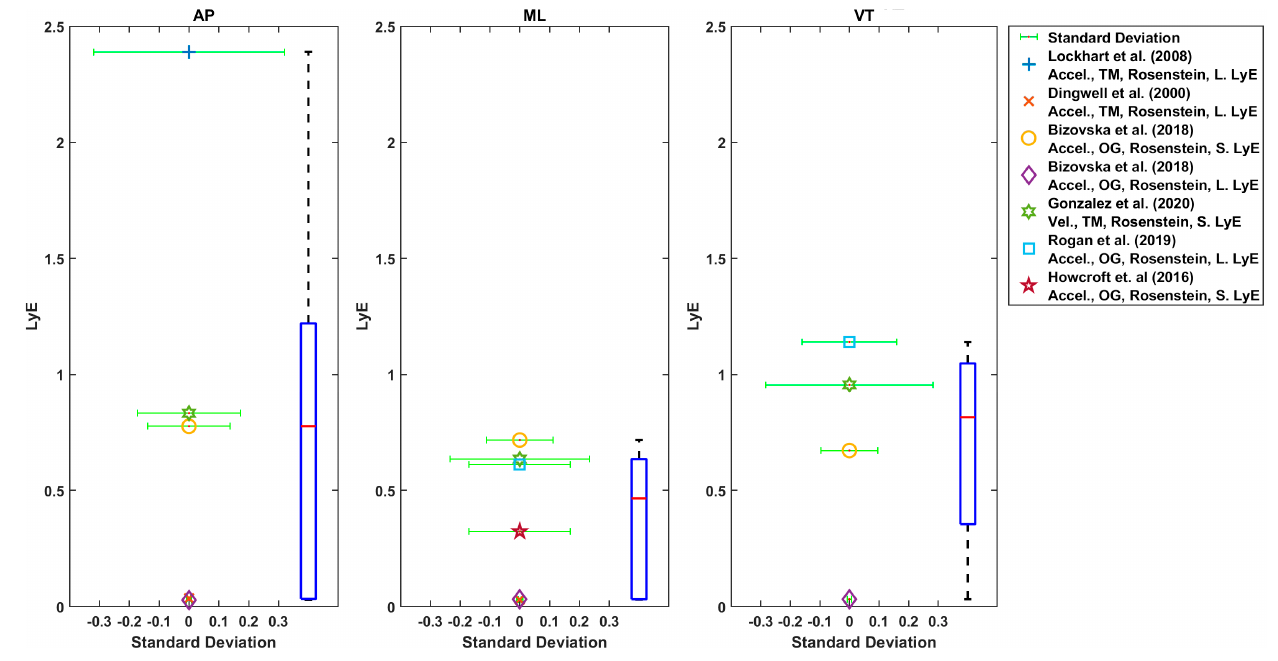
Figure 7. Reported Trunk Short-Term LyE or Long-Term LyE for fall-prone adults.